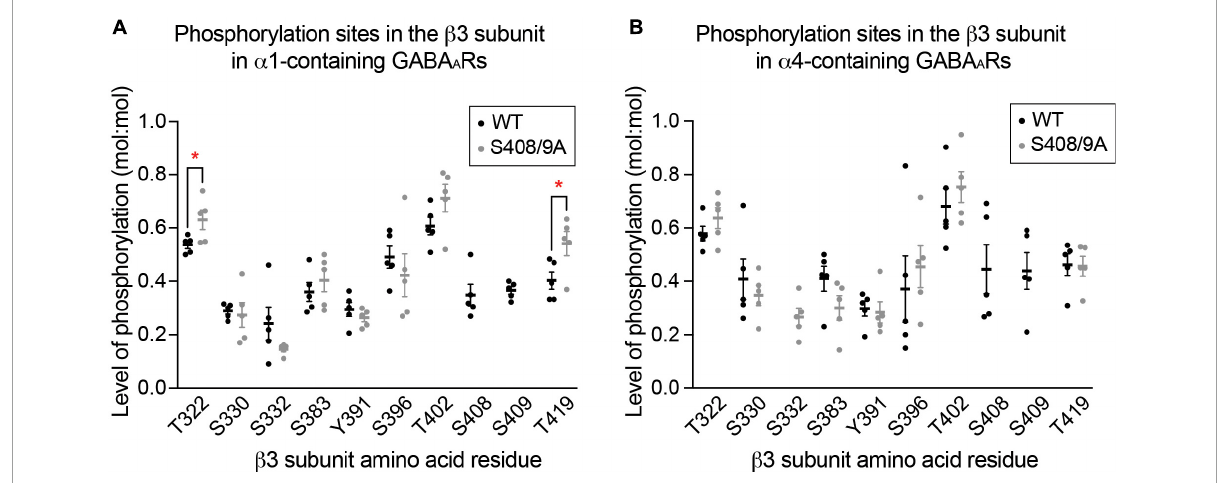
FIGURE7 The S408/9A mutation does not lead to gross changes in global β 3 subunit phosphorylation. (A) Phosphorylated residues within the β 3 subunit of α 1-containing GABA A Rs are compared between WT and S408/9A mice. The mutation does not induce aberrant phosphorylation on the β 3 subunit, as indicated by the detection of the same phosphorylation sites in WT and S408/9A mice. Two sites – T322 and T419 – are more highly phosphorylated in S408/9A than in WT mice (* p < 0.05, n = 5 replicates). (B) Phosphorylated residues within the β 3 subunit of α 4-containing GABA A Rs from WT and S408/9A mice are shown. Phosphorylated S332 was only detected in the α 4 subtype from S408/9A mice ( n = 5